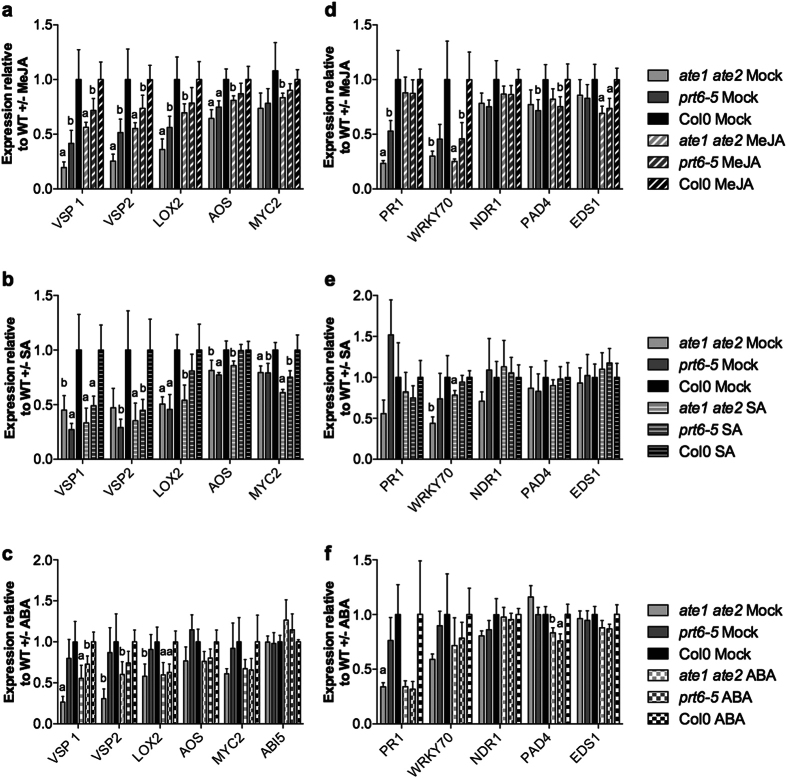
The regulation of JA response genes is affected in ate1 ate2 mutant seedlings.The results presented in Supplementary Fig. 3 were used to calculate the gene expression changes in the ate1 ate2 and prt6-5 mutants relative to those in wild-type seedlings for mock and hormone-treated seedlings, respectively. (a) Relative expression of JA response genes following mock or 20 μM MeJA treatment. (b) Relative expression of JA response genes following mock or 0.5 mM SA treatment. (c) Relative expression of JA response genes following mock or 10 μM ABA treatment. (d) Relative expression of SA response genes following mock or 20 μM MeJA treatment. (e) Relative expression of SA response genes following mock or 0.5 mM SA treatment. (f) Relative expression of SA response genes following mock or 10 μM ABA treatment. Error bars correspond to SEM of at least four independent biological replicates. The results of Student’s t-tests are shown with ‘a’ indicating P-values < 0.05 and ‘b’ P-values between 0.05 and 0.1. VSP1: VEGETATIVE STORAGE PROTEIN1; VSP2: VEGETATIVE STORAGE PROTEIN2; LOX2: LIPOXYGENASE2; AOS: ALLENE OXIDE SYNTHASE; PR1: PATHOGENESIS-RELATED1; NDR1: NON RACE-SPECIFIC DISEASE RESISTANCE1; PAD4: PHYTOALEXIN DEFICIENT4; EDS1: ENHANCED DISEASE SUSCEPTIBILITY1; ABI5: ABA INSENSITIVE5.